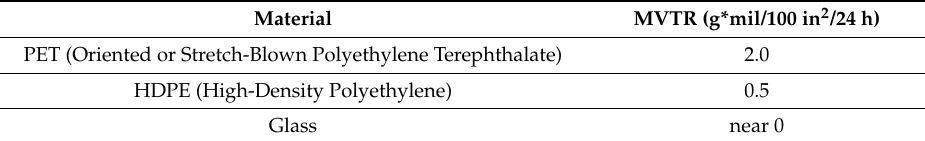
Table 5. Examples of moisture vapor transmission rates (MVTR) for commonly used bottle types for probiotic dietary supplement products (from the Alpha Packaging Plastics Comparison Chart